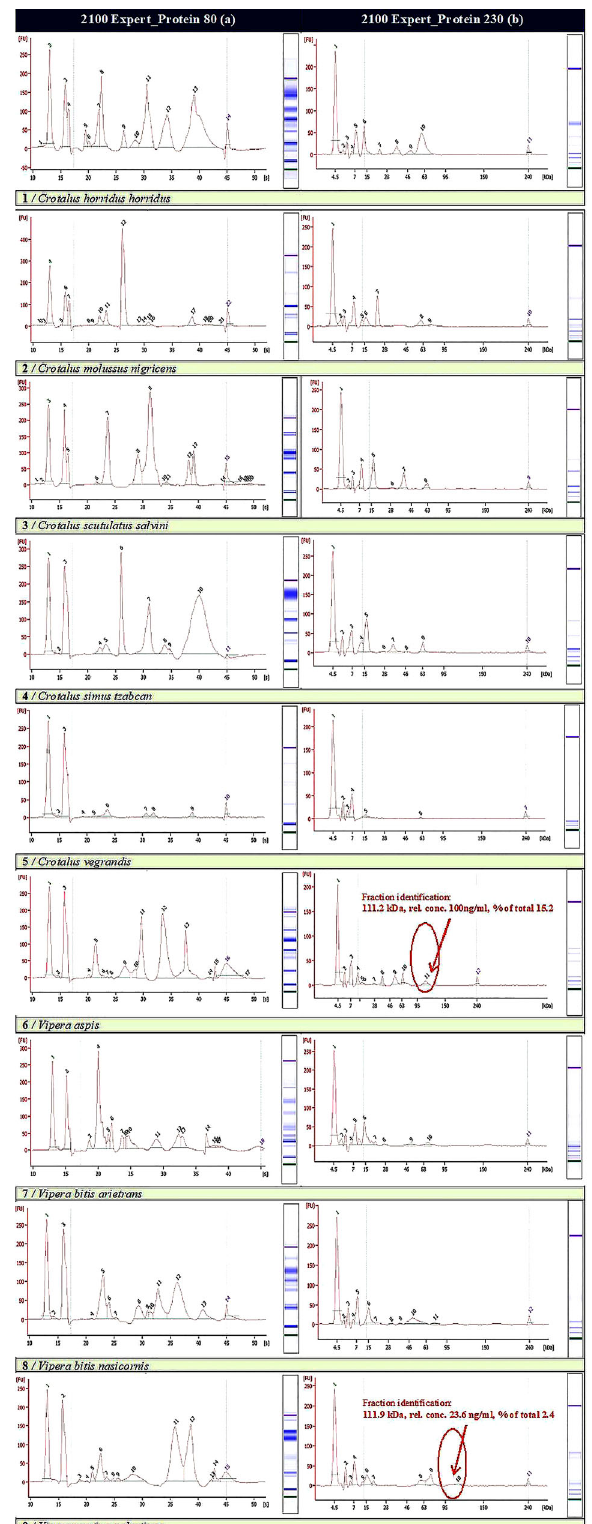
Figure 2. Electropherograms of lyophilized venom samples showing peak detection, and quantity and quality of detected protein fractions: a ) Protein 80 and b ) Protein 230, using Protein 2100 Expert Testing